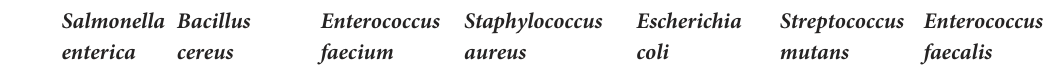
Inhibition zone,